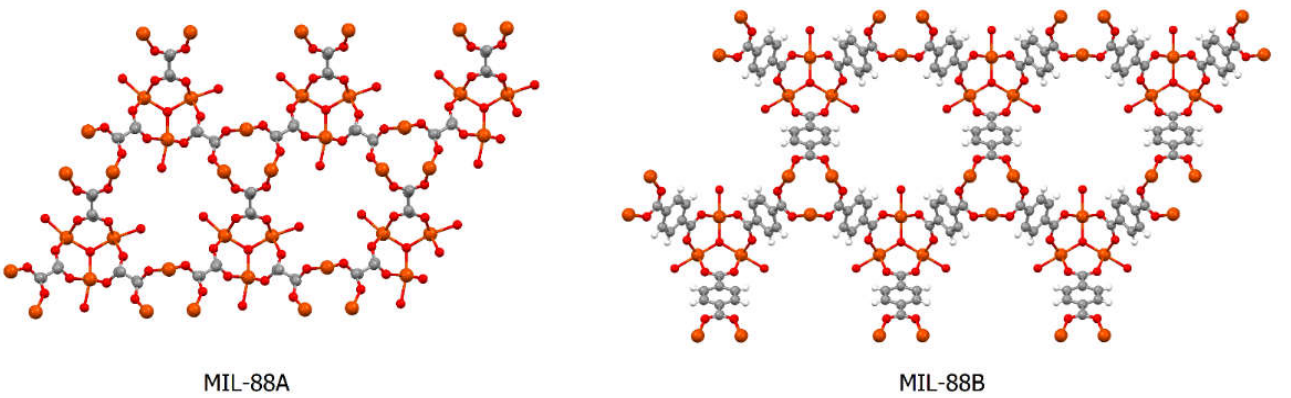
Figure 1. Structural representation of MIL-88A ( left ) and MIL-88B ( right ), with carbon atoms rep- resented in grey, oxygen atoms in red and iron atoms in orange; solvent molecules are omitted for clarity. Drawn with the software Mercury 3.5.1 (Copyright CCDC 2001–2014) from the atomic coordinates of MIL-88A (refcode FAVKAP) and of MIL-88B (refcode HAMXIG), available at the Cambridge Structural Database.